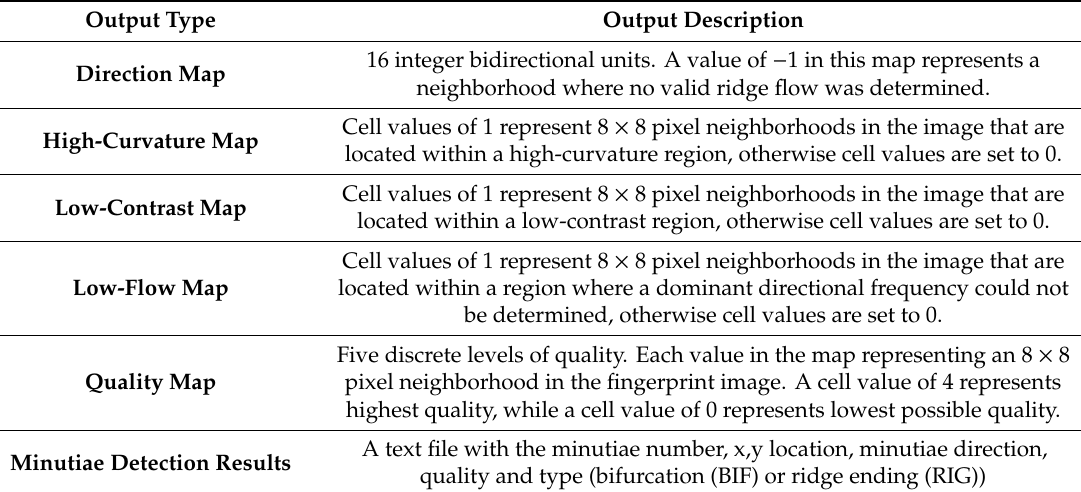
Table 1. MINDTCT